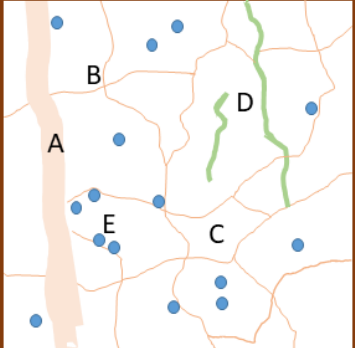
Figure 1. Schematic illustration of the conceptual model with the soil pore space comprising macropores (A), mesopores (thin lines; B) and micropores (C) and with two qualities of organic matter, namely particulate organic matter (POM; e.g. decaying roots; green lines; D) and microbially processed organic matter (blue circles; E), both of which are stored either in contact only with micropores (and therefore partially protected from decomposition) or in contact with mesopores.